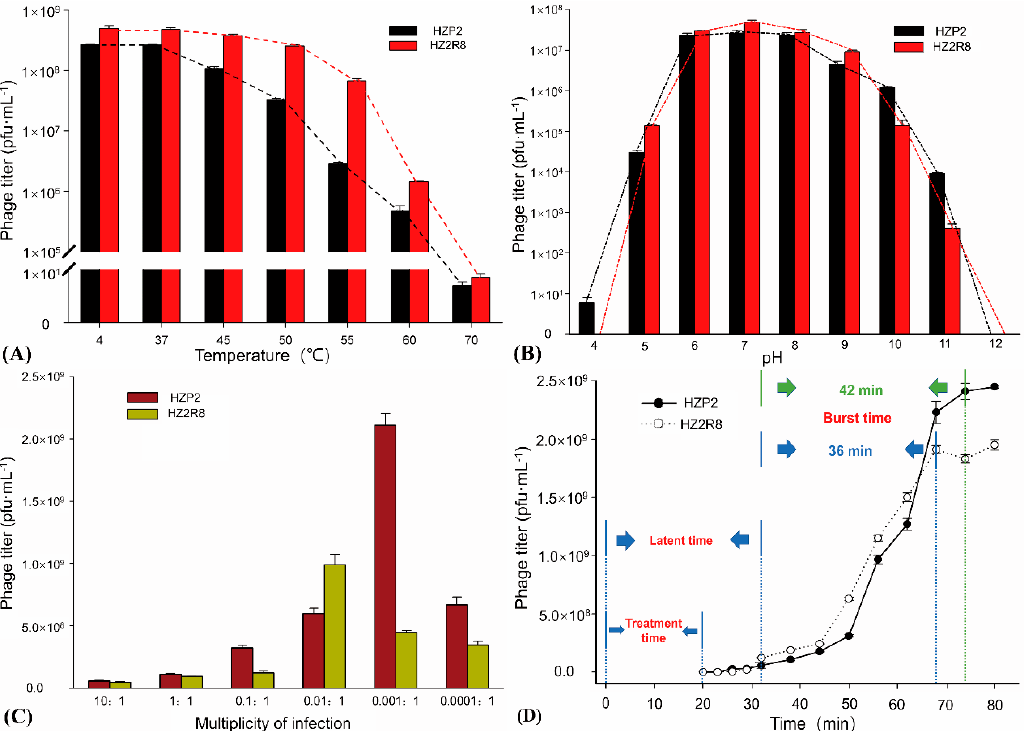
Figure 2. General features of phage HZP2 and HZ2R8. ( A ) Thermal stability test of phage HZP2 and HZ2R8. ( B ) pH stability test of phage HZP2 and HZ2R8. ( C ) Multiplicity of infection (MOI) experiments of phage HZP2 and HZ2R8. ( D ) One step-growth cure of phage HZP2 and HZ2R8.